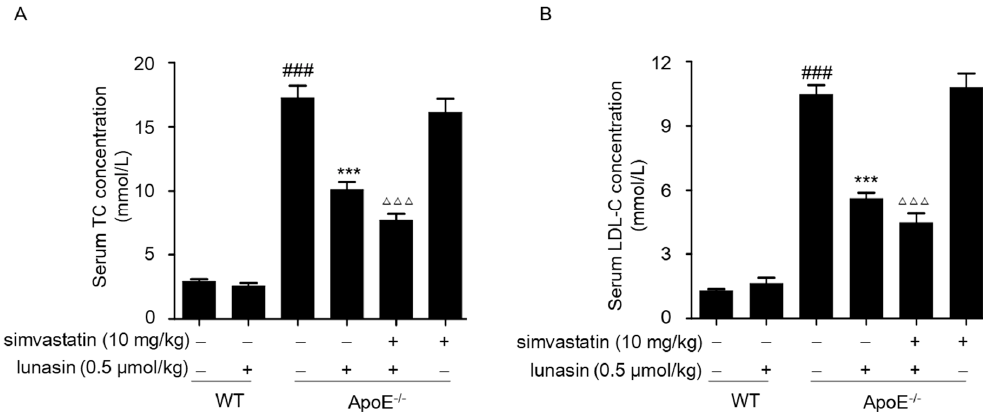
Figure 5. Effects of combined drug on serum cholesterol levels in ApoE − / − mice fed with HFD. ApoE − / − mice were i.p. administrated with 10 mg/kg simvastatin and/or 0.5 μ mol/kg lunasin on daily basis for four weeks. LDL-C ( A ) and TC ( B ) concentrations in serum samples were measured by biochemical kits. ### p < 0.001 vs. C57BL/6 mice administrated with normal saline (NS); *** p < 0.001 vs. ApoE − / − mice administrated with NS; ΔΔΔ p < 0.001 vs. ApoE − / − mice administrated with simvastatin ( n = 8, means ± SEM).